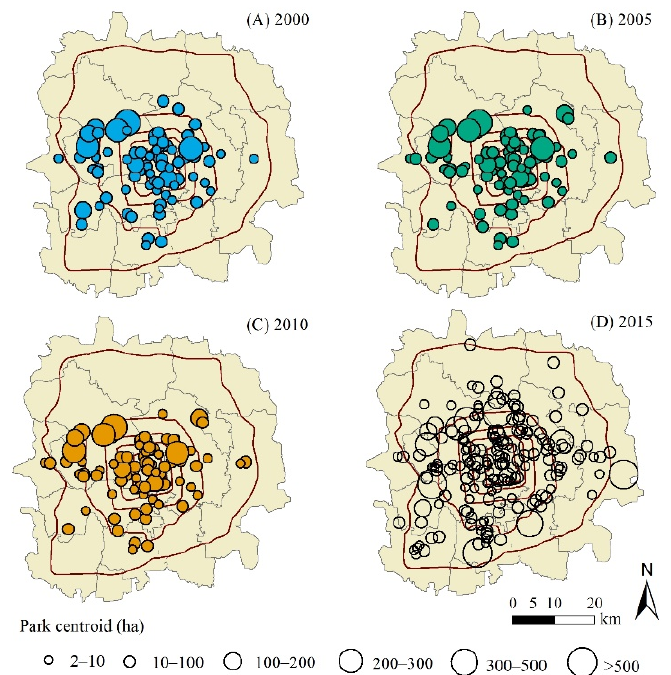
Figure 2. The distribution of the centroids of urban parks in 2000 ( A ), 2005 ( B ), 2010 ( C ), and 2015 ( D ) in Beijing.